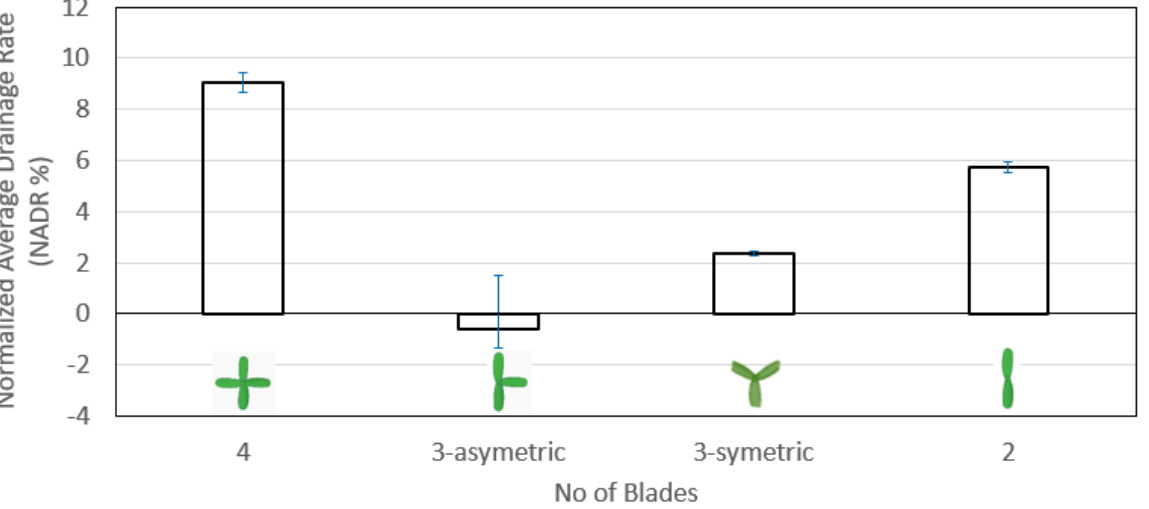
Figure 11. Effect of asymmetricity on the tank drainage rate (d r /d o = 1.73).